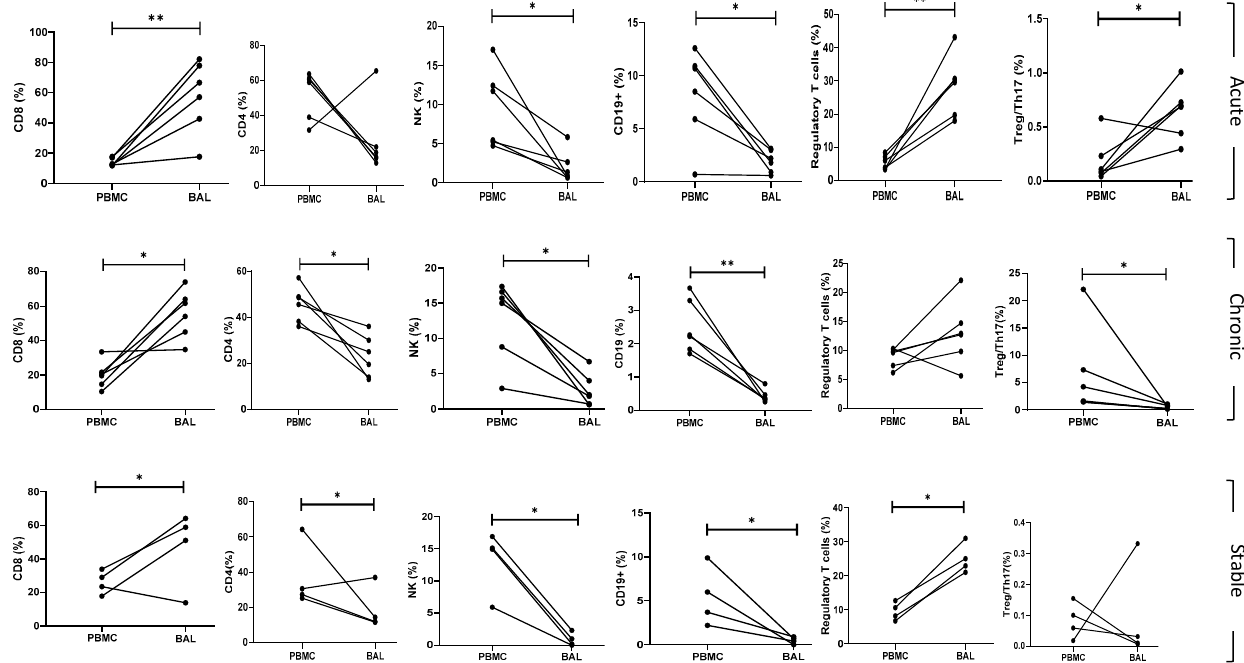
Figure 8. Data represent comparison analysis on BAL and PBMC, mean (center bar) ± SEM (upper and lower bars). If not indicated, p value is not significant. * p < 0.05, ** p < Fig. 8. Data represent comparison analysis on BAL and PBMC. mean (centre bar) ± SEM (upper and lower bars). If not indicated. p value is not significant. *p<0.05. **p<0.01. ***p<0.001.